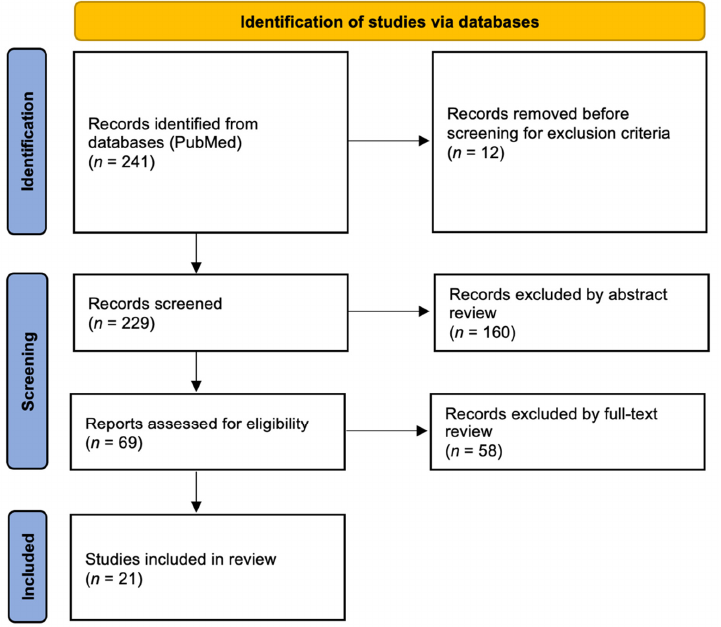
Figure 2. Flow diagram of study design in accordance with PRISMA 2020 guidelines.